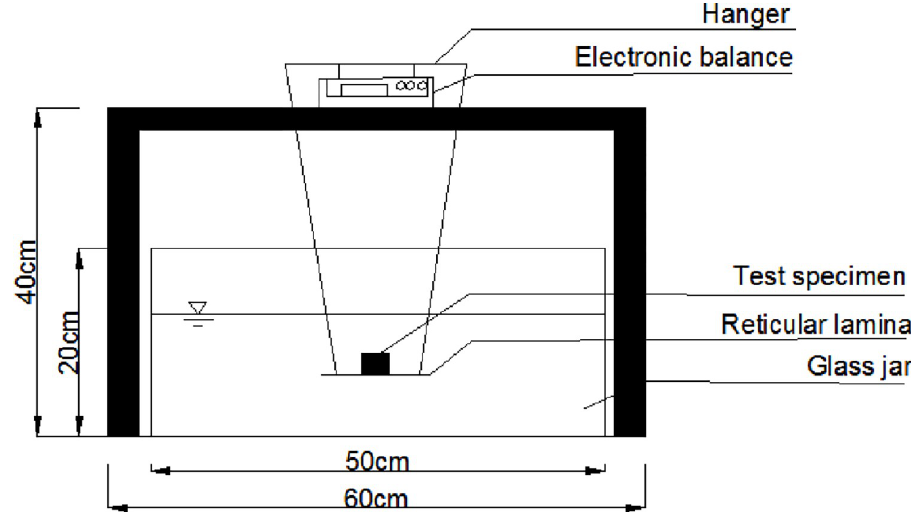
Fig 1. Schematic diagram of disintegration device.